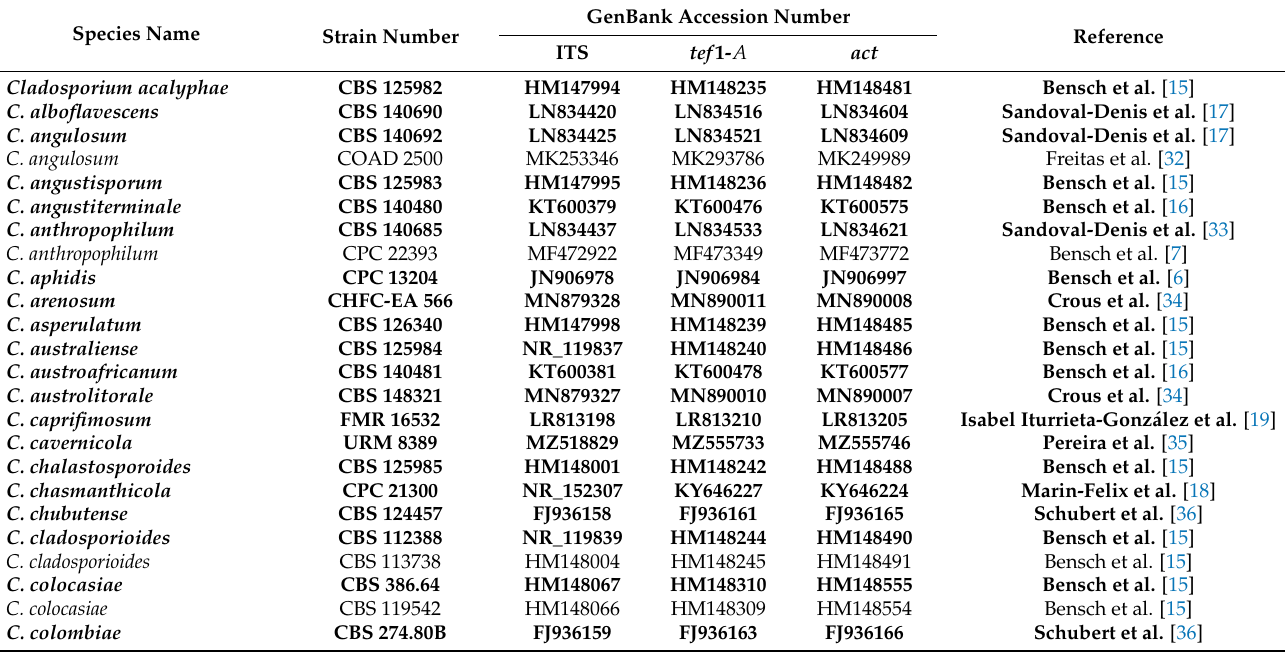
Table 2. Cladosporium strains and their corresponding DNA sequences, which were used in the phylogenetic analyses (ex-type strains are indicated in